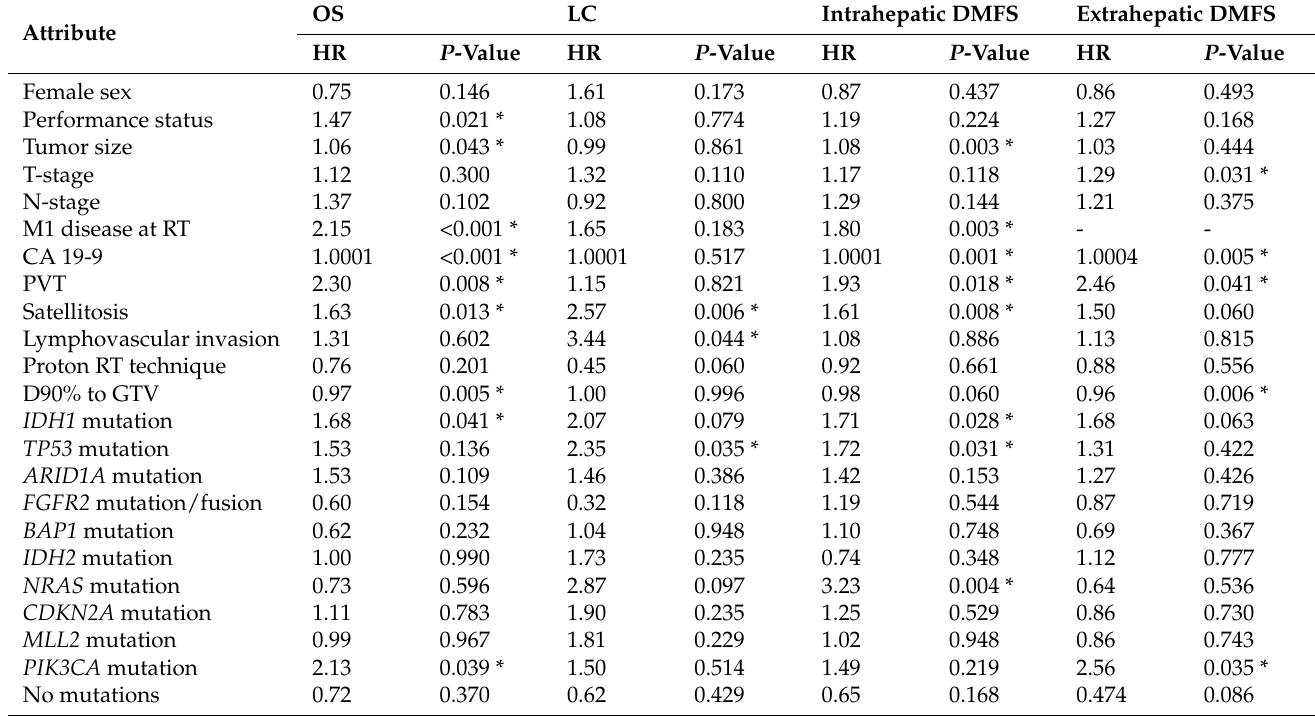
Table 3. Univariate Cox analysis of factors associated with time-to-event outcomes following initiation of ablative